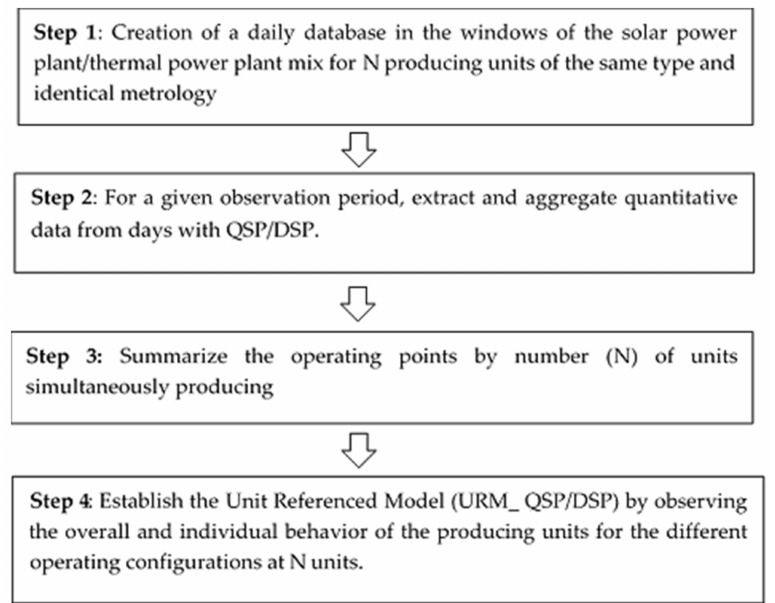
Figure 16. Method of developing URM_QSP/DSP consumption